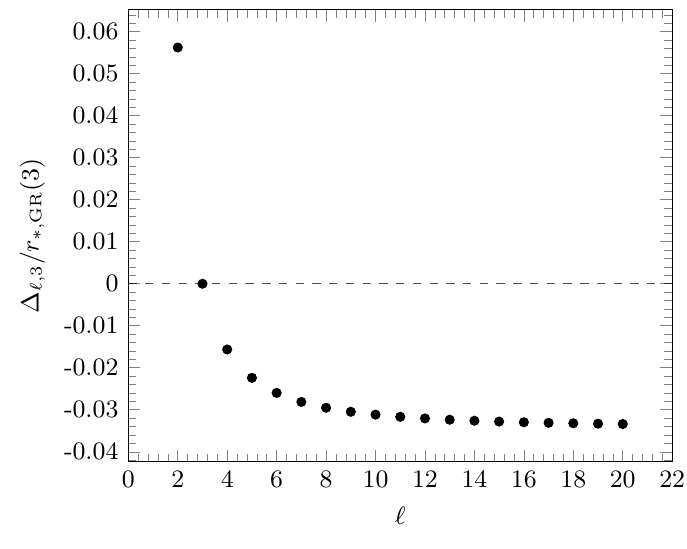
( ‘ ) corresponding to ; GR (cid:3) of the ; GR (cid:3)